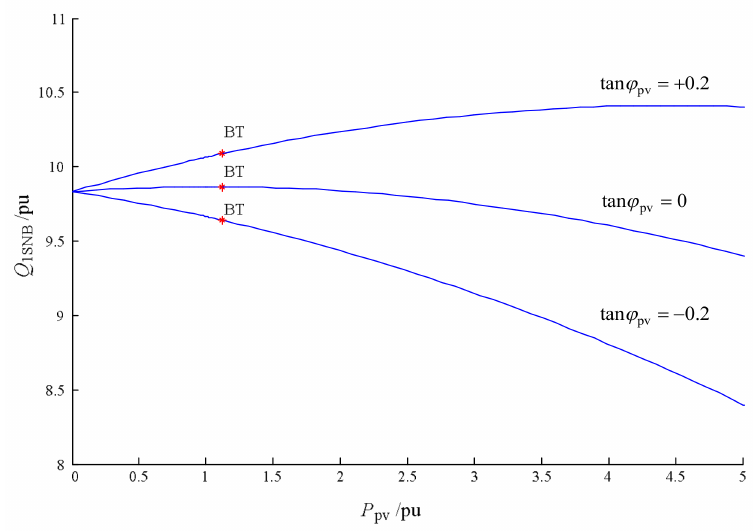
Figure 3. The P pv - Q 1SNB double-parameter bifurcation